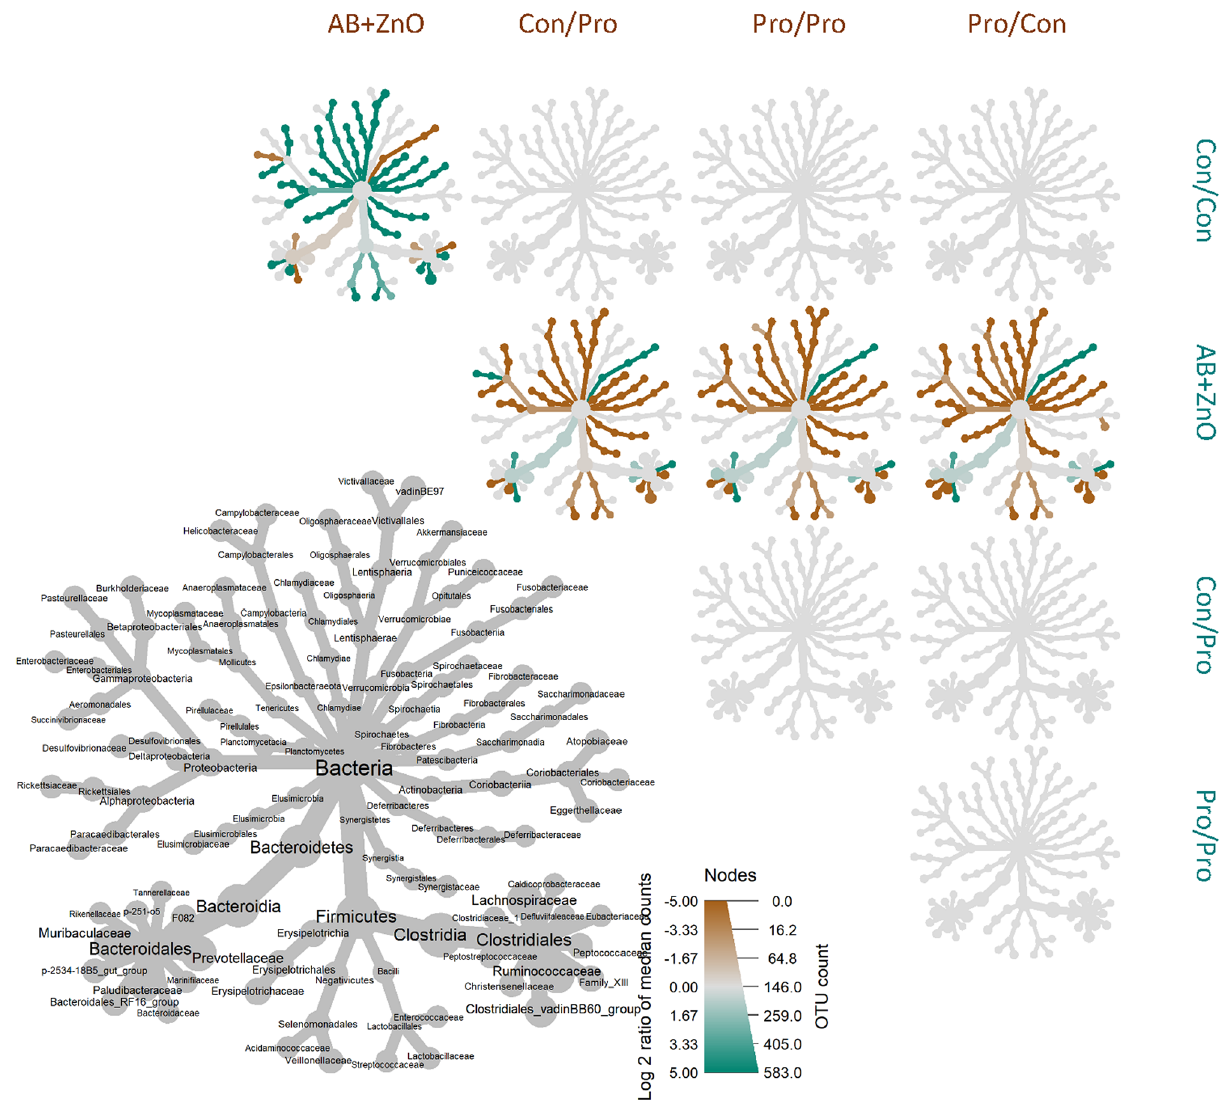
Figure 3. Phylogenetic trees showing pairwise comparisons of the relative abundances of all bacterial families (including those at < 1% relative abundance) within the faecal microbiota between treatments at D27 post- weaning (treatments indicated along the top of the figure are compared with those listed down the right-hand side). Taxa that are relatively more abundant in the treatments indicated at the top of the figure compared to those on the right are indicated in brown, while those that are less abundant are shown in green. The colour gradient indicates the difference in fold change between treatments for the relative abundance of a certain